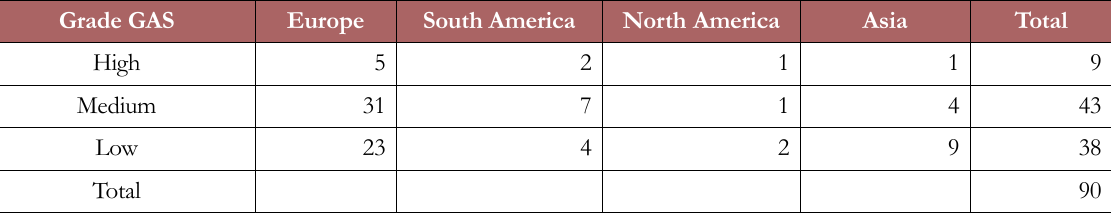
Table 3. Supplier classification according to Global Audit